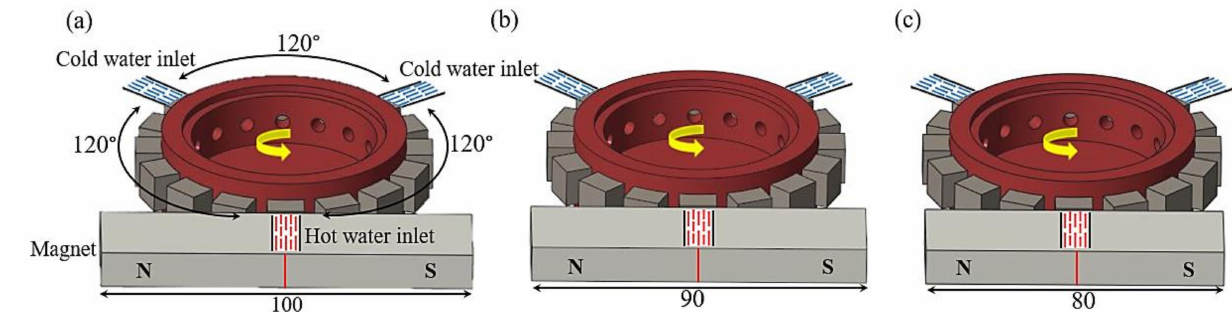
Figure 3. Simulated models of a thermomagnetic heat engine, consisting of different sizes of magnets and two cold- and a hot-water inlet located at an angle of 120 ◦ : ( a ) thermomagnetic engine consists of 100 mm magnet, ( b ) thermomagnetic engine consists of 90 mm magnet, ( c ) thermomagnetic engine consists of 80 mm magnet, ( d ) thermomagnetic engine consists of 70 mm magnet, ( e ) thermomagnetic engine consists of 60 mm magnet, and ( f ) thermomagnetic engine consists of 50 mm magnet.